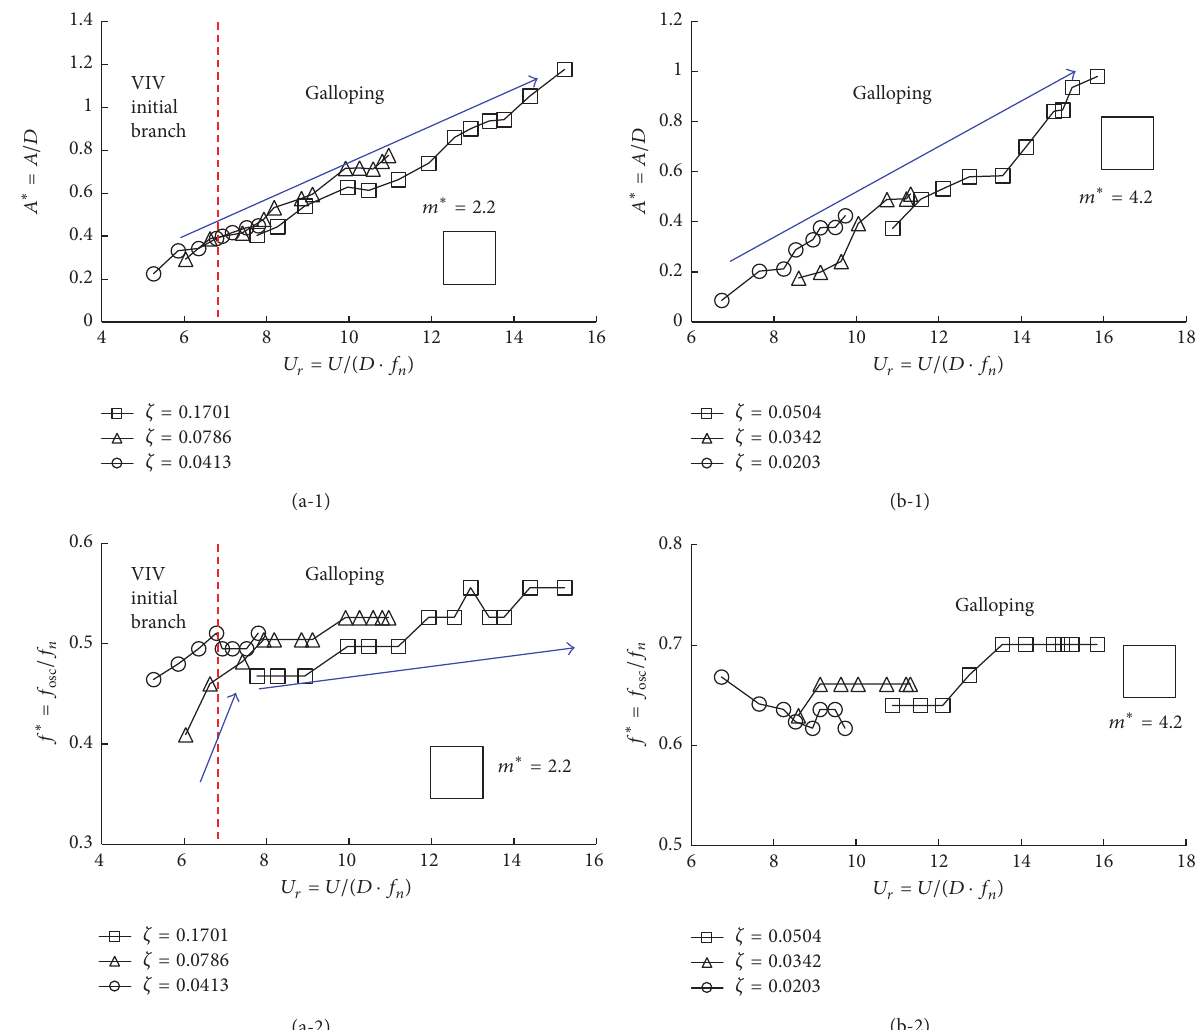
Figure 9: Variations of the amplitude ratios and the frequency ratios against the reduced velocities for right square prism. Amplitude ratio 𝐴 ∗ = 𝐴/𝐷 ; frequency ratio 𝑓 ∗ = 𝑓 the natural frequency. (a-1) The responses of amplitude ratios, 𝑚 ∗ = 2.2 ; (a-2) the responses of frequency ratios, 𝑚 ∗ = 2.2 ; (b-1) the responses of amplitude ratios, 𝑚 ∗ = 4.2 ; (b-2) the responses of frequency ratios, 𝑚 ∗ = 4.2 .